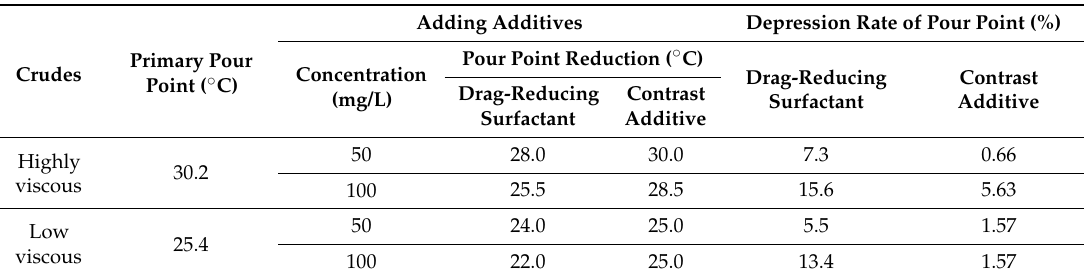
Table 1. Pour point of the crudes before and after the drag ‐ reducing surfactant addition.